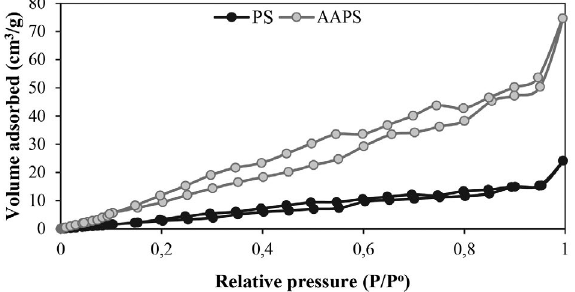
Fig. 5. The nitrogen adsorption–desorption isotherm of PS and AAPS.